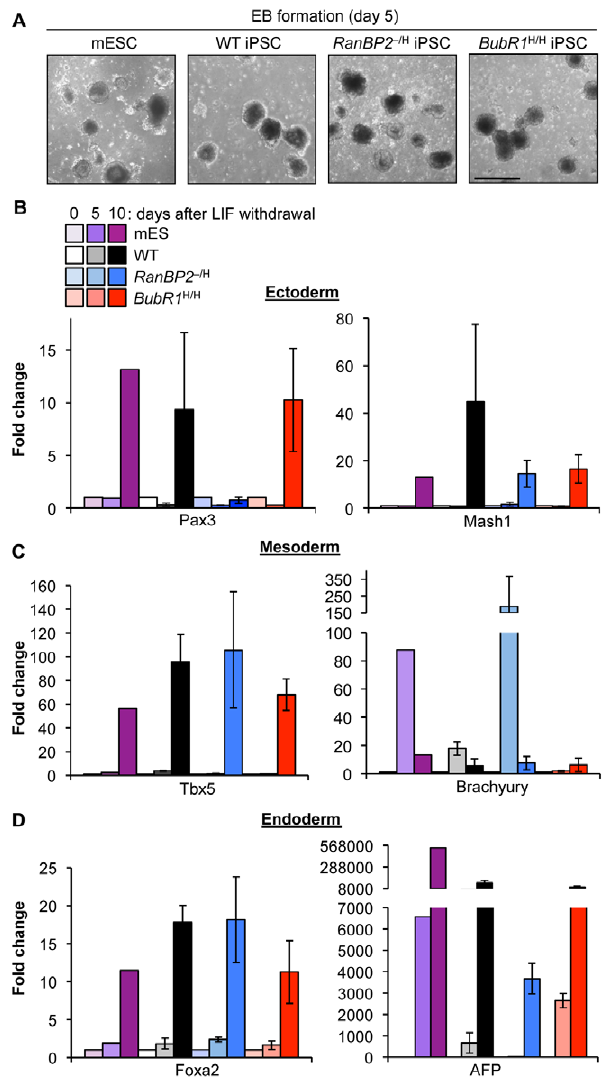
Figure 2. iPSCs from W-CIN mutant MEFs differentiate into EBs comprising of all embryonic germ layers. (A) Representative EBs derived from mESCs and iPSC clones. (B–D) qRT-PCR analysis of EBs derived from mESCs and iPSC clones for expression of the indicated embryonic germ layer markers. Error bars represent SEM.